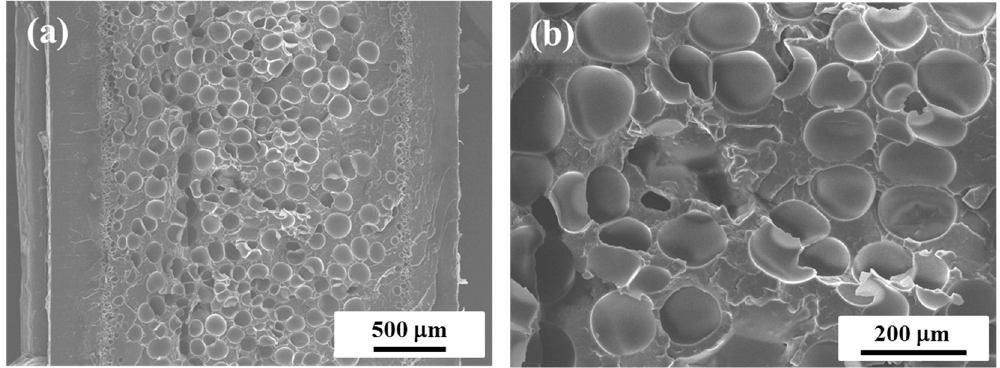
Figure 1. Typical SEM micrographs of: ( a ) the injection-molded isotactic polypropylene (iPP) foams; ( b ) the enlarged image of the core layer of (a).